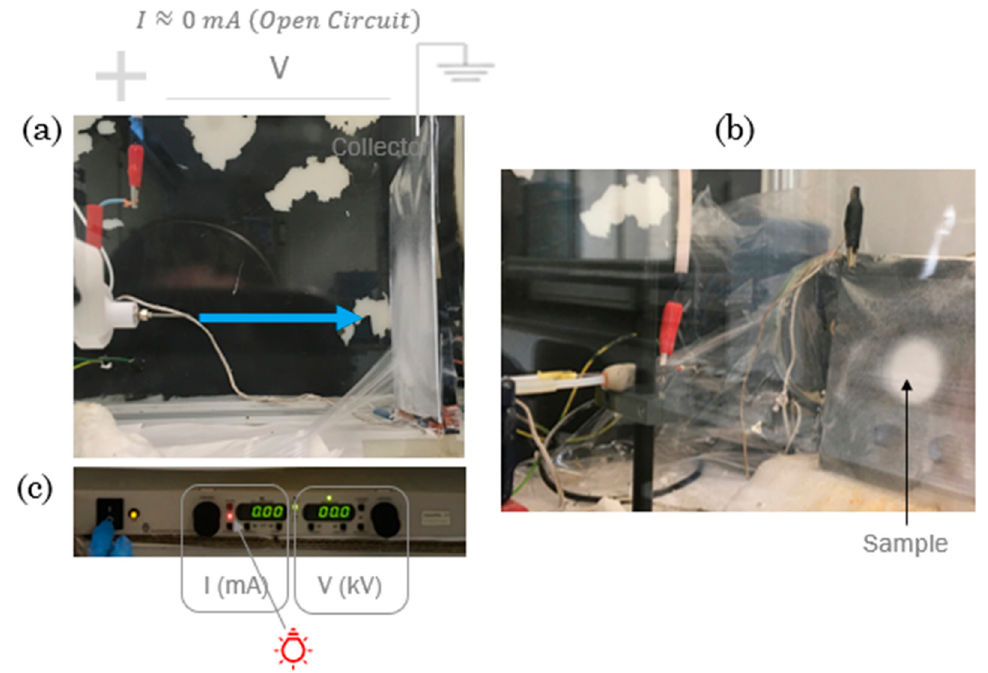
Figure 3. Coaxial electrospinning assembly ( a ), sample visualization ( b ), and high voltage source, where intensity (I) in mA and voltage (V) in kV are displayed ( c ).